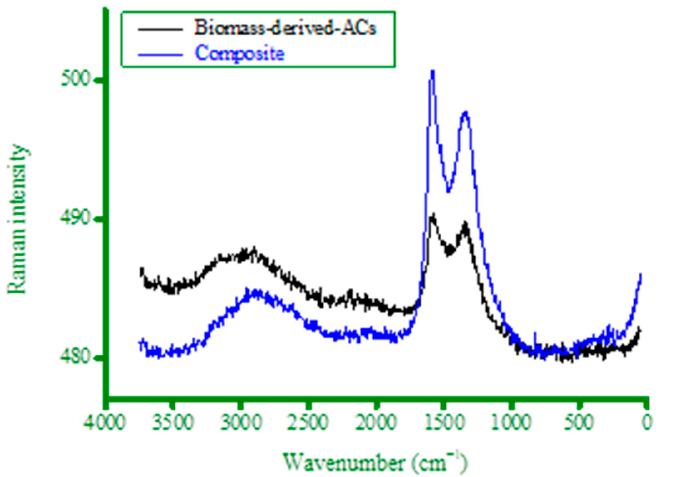
Figure 6. Raman spectra of biomass-derived-ACs, and the Fe 3 O 4 -carbon-based composite.